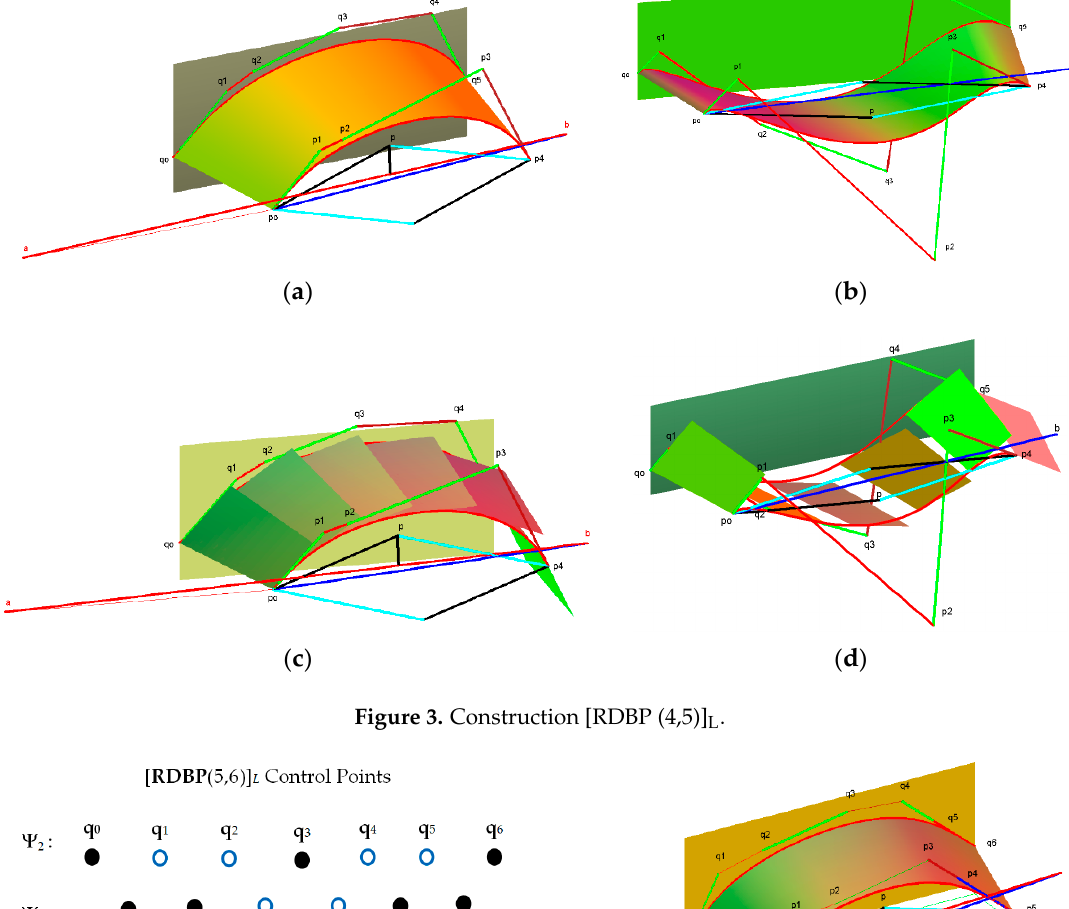
Figure 3. Construction [RDBP (4,5)] L .